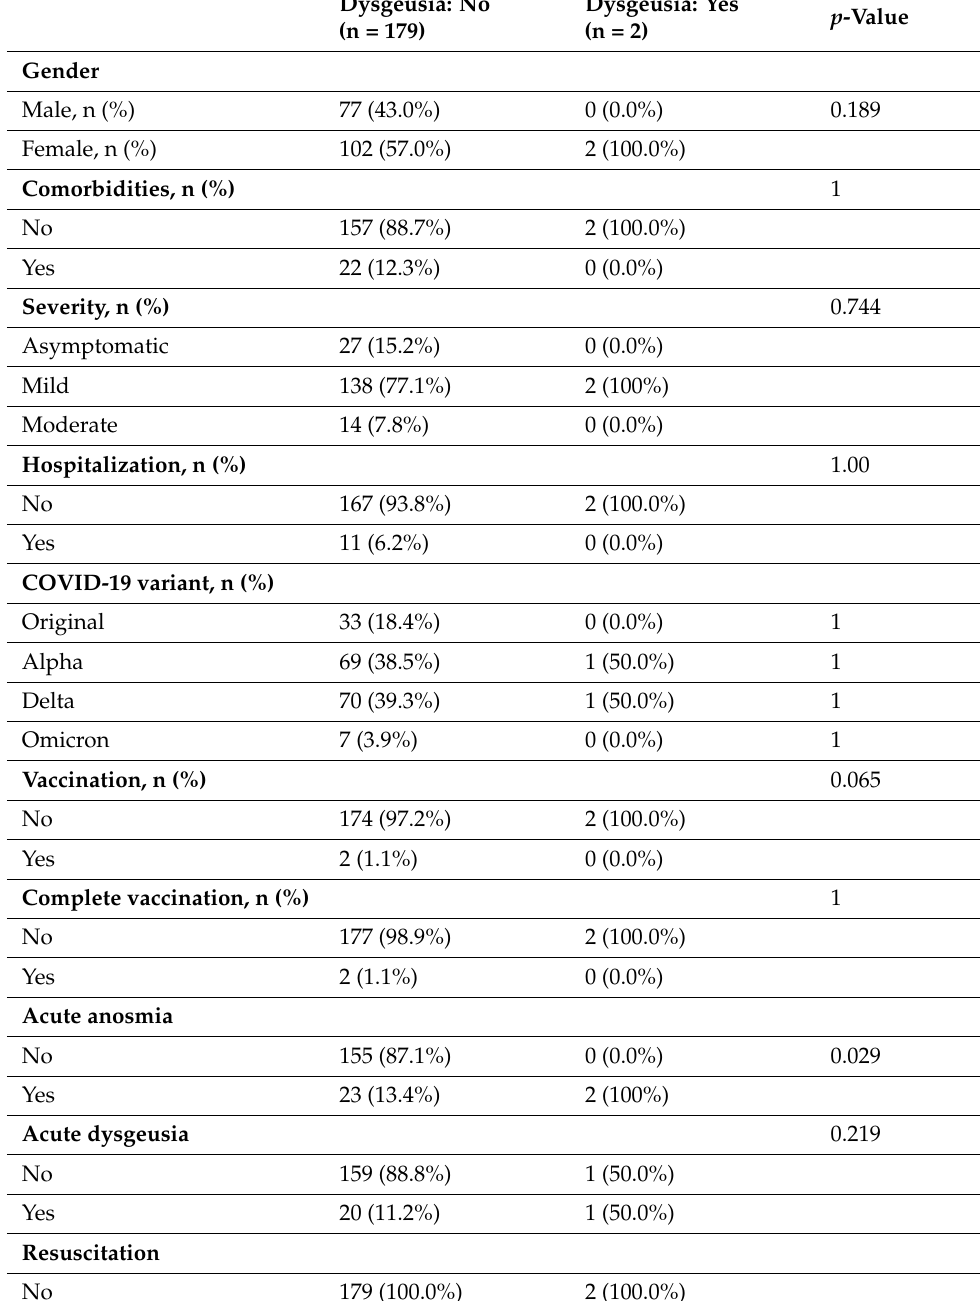
Table 8. Dysgeusia at FUP